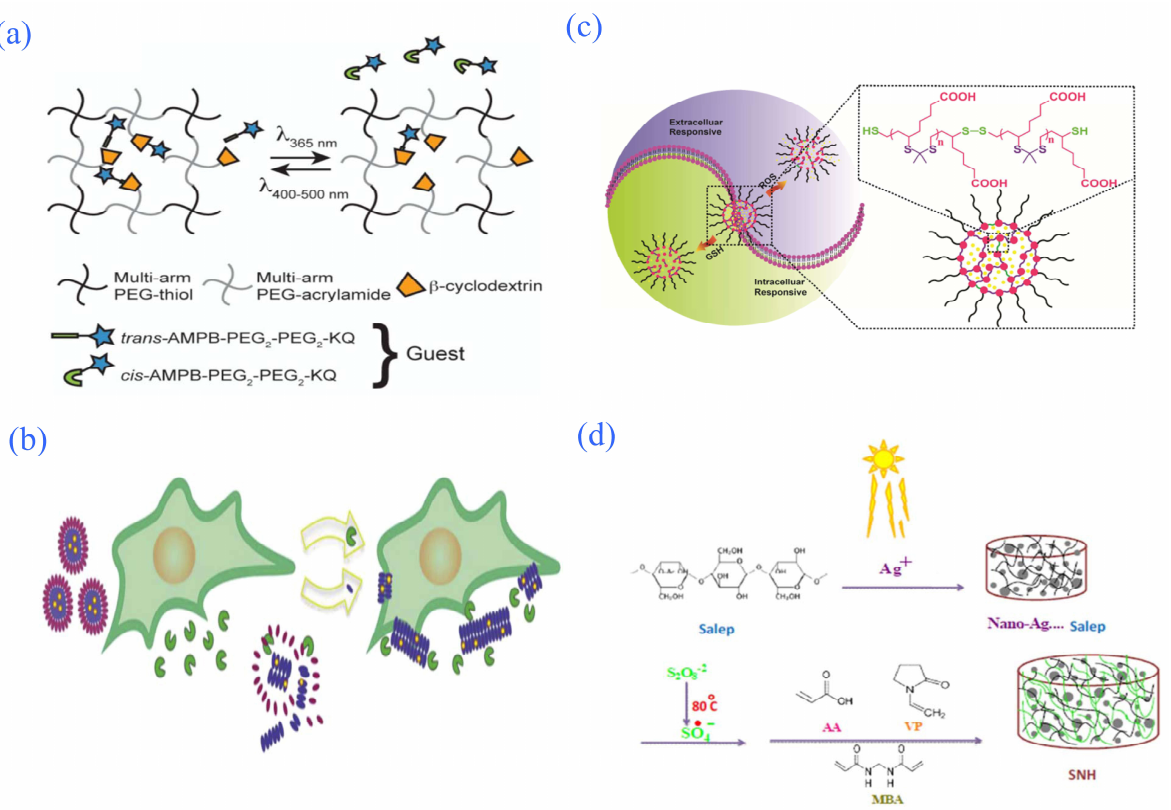
Figure 7. Partial intelligent-response hydrogel controlled-release system. ( a ) Schematic of photoinitiated release of an azobenzene functionalized drug from a β-cyclodextrin-containing PEG-based reservoir. Reprinted with permission from Ref. [108]. Copyright 2016, Nehls, E.M. ( b ) Schematic diagram of the killing effect of enzyme-responsive injectable hydrogels on cancer cells. Reprinted with permission from Ref. [113]. Copyright 2016, Kalafatovic, D. ( c ) Redox-responsive controlled-release system based on TKN hydrogel. Reprinted with permission from Ref. [114]. Copyright 2018, Chen, D. ( d ) Proposed mechanism for preparation of SNH. Reprinted with permission from Ref. [116]. Copyright 2016, Hooshyar, Z.